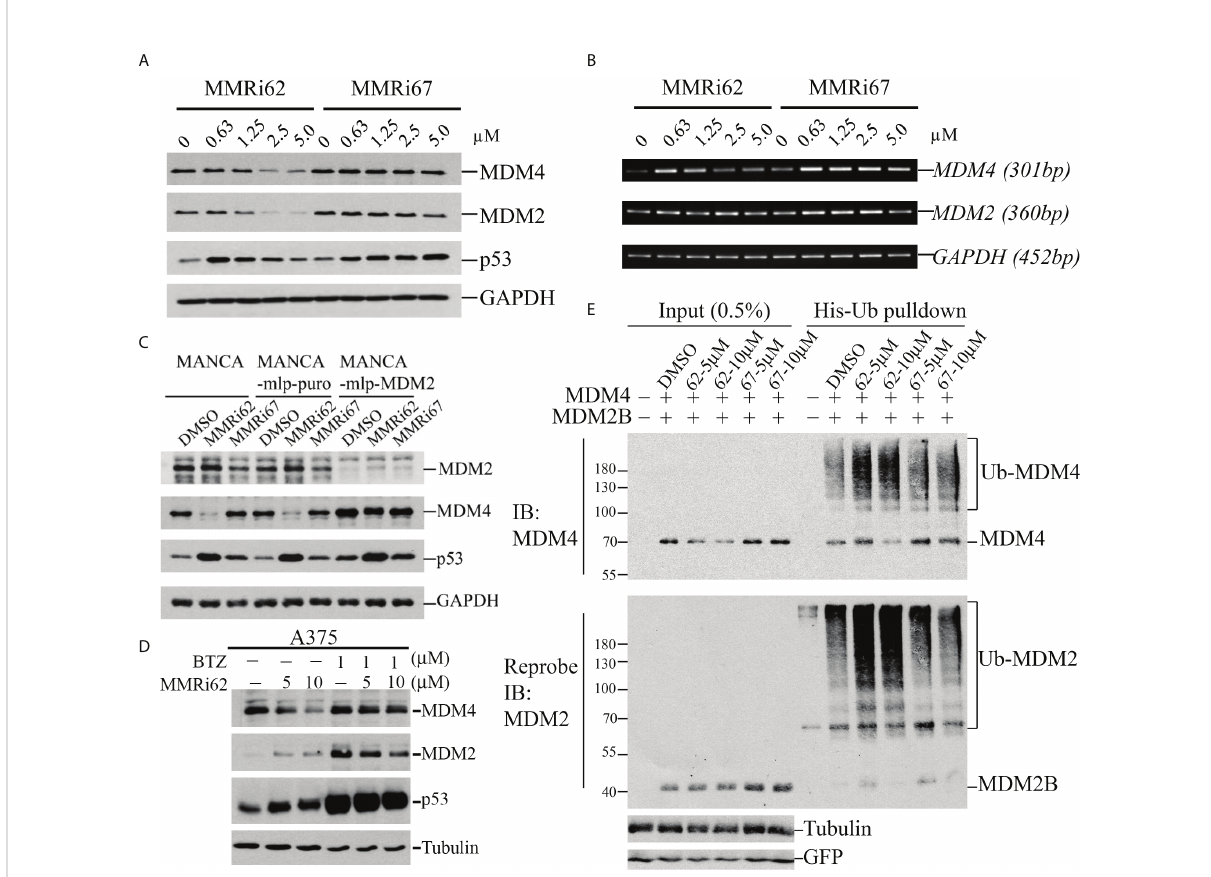
FIGURE 3 MMRi62 induces MDM2-dependent degradation of MDM4 protein in cells. (A) Western blotting analysis of the effects of MMRi62 and MMRi67 on expression levels of p53, MDM2, and MDM4 in NALM6 cells treated for 24 h at the indicated concentrations. (B) RT-PCR analysis of the effects of MMRi62 and MMRi67 on p53 , Mdm2 , and Mdm4 mRNA expression in the same NALM6 samples prepared in panel (A) . (C) Results demonstrating that MDM2 is required for MMRi62-induced degradation of MDM4 proteins in cells. The Western blotting (WB) analysis was performed as in panel A except in MANCA cells, or cells stably expressing empty vector mlp (MANCA-mlp-puro) or stably expressing MDM2- mcRNA (MANCA-mlp-MDM2); cells were treated with 5 m M of MMRi62 or MMRi67. (D) Western blotting analysis of MDM4 degradation by MMRi62 rescued by proteasome inhibition with bortezomib (BTZ); in these experiments, A375 cells were treated with MMRi62 for 24 h with or without BTZ for 16 h before cell harvest. (E) MMRi62 induced increased ubiquitination of MDM4 and MDM2 in 293 cells during in vivo ubiquitination assays. The 293 cells were transfected with vectors expressing MDM2B, FLAG-MDM4, His-ubiquitin, and green fl uorescent protein (GFP). Cell lysates were prepared 24 h after transfection and used for His-tag pulldown followed by WB with anti-FLAG (for MDM4) and anti- MDM2 (mAb 4B11). Ubiquitinated MDM4 and MDM2B are indicated. GFP was used for the internal control of transfection ef fi ciency and protein